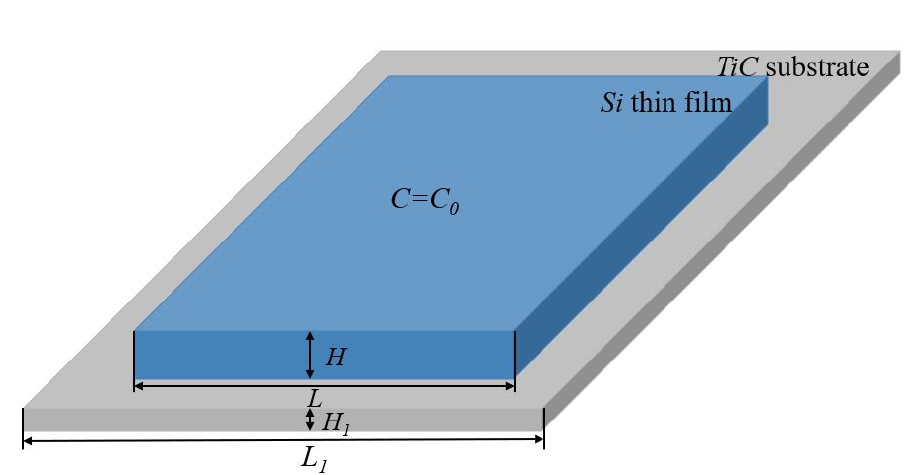
Figure 2. The Si thin film was deposited on the TiC substrate and the boundary conditions for the analysis of the Si thin film in the processes of lithiation and